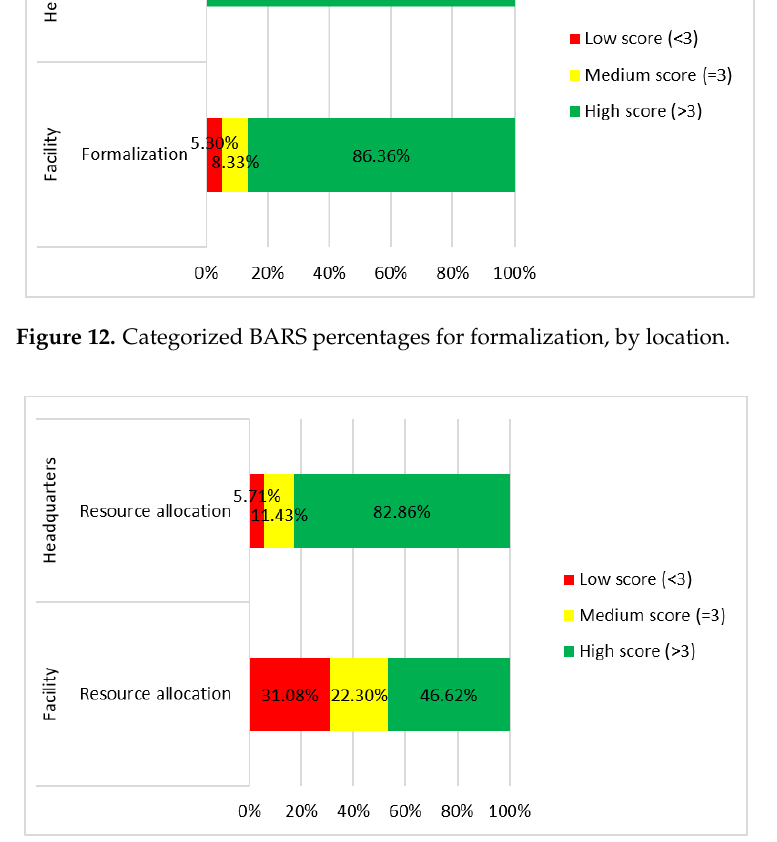
Figure 13. Categorized BARS percentages for resources allocation, by location.